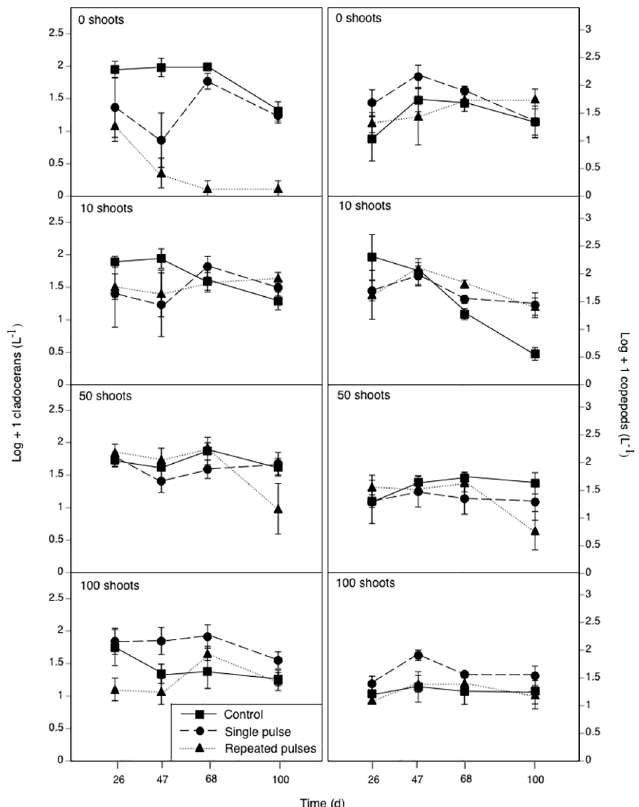
Fig 2. The effects of different malathion exposure scenarios in the presence of four Elodea treatments planted with different initial numbers of plant shoots on cladoceran density (left) and copepod density (right) over time. Data are means ± 1